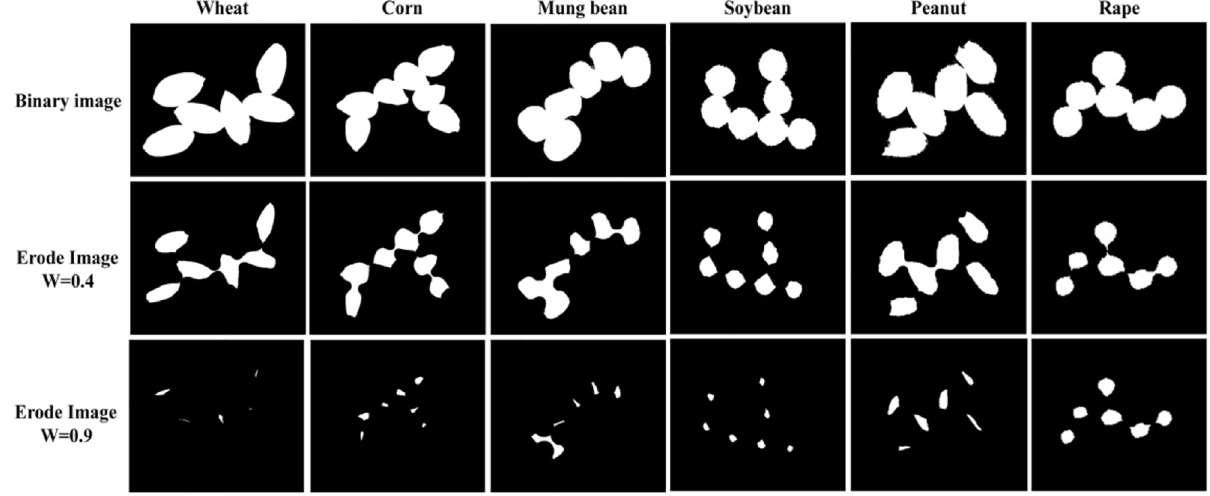
Fig 5. Corrosion results of 6 kinds of grains based on different coefficients of short axis. Note: The three rows are binary graphs; 0.4 � minor axis of the corrosion factor, and 0.9 � minor axis of the corrosion factor.